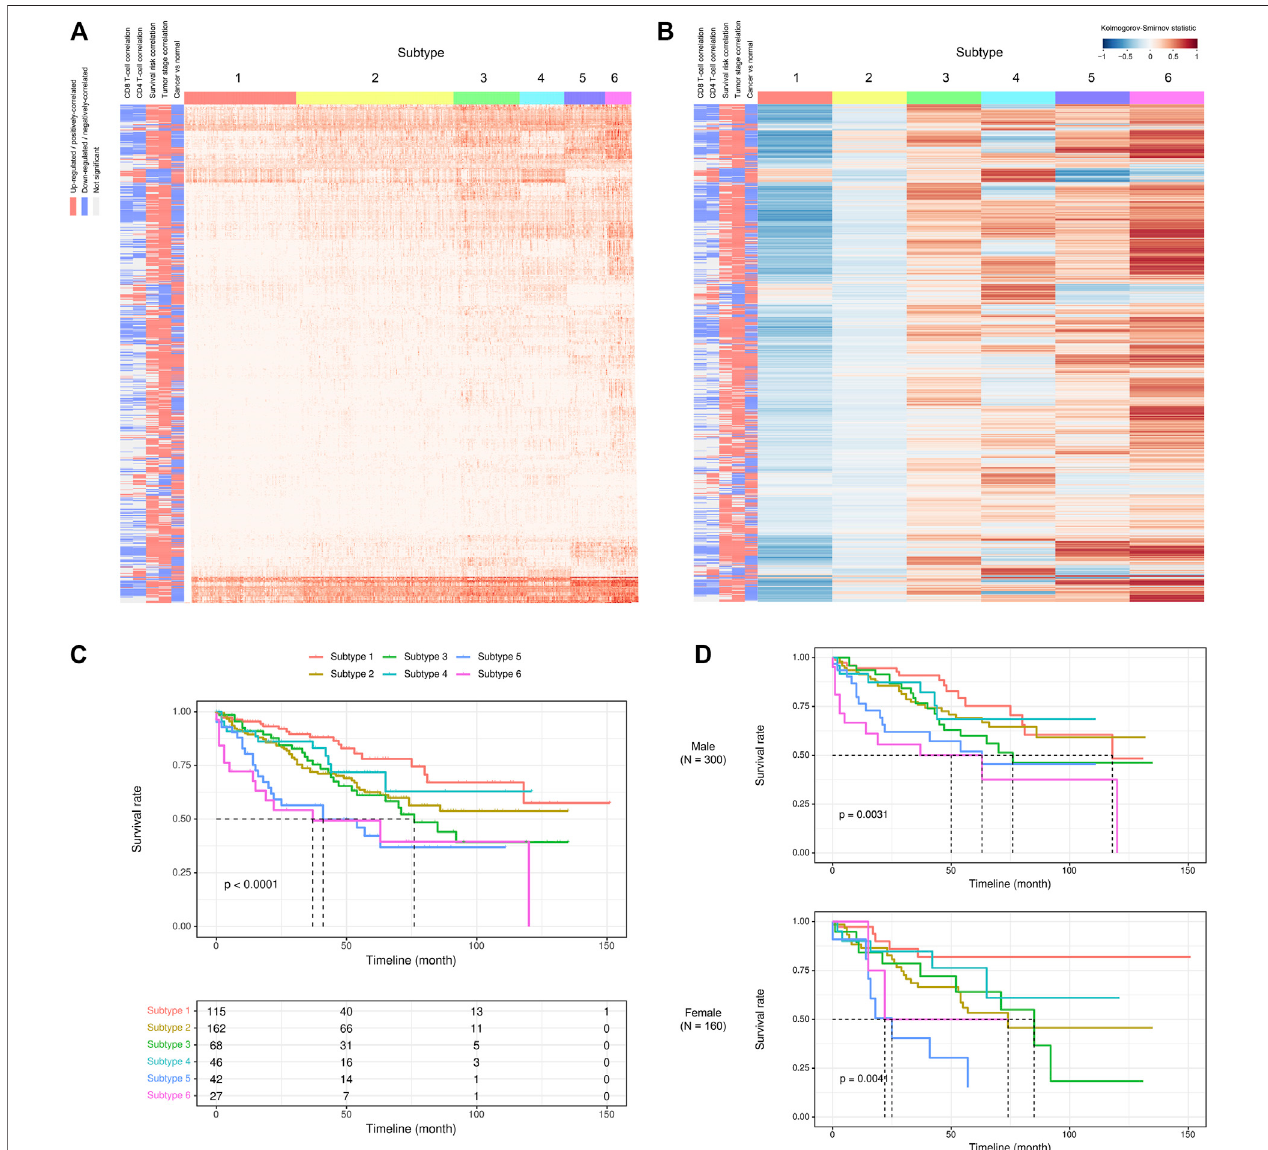
FIGURE7| ca-tRF-basedsubtypesandcorrespondingsurvivaldistinctioninKIRC. (A) Thesubtypessuggestedbyca-tRFexpressionpattern.Columnsandrows represent samples and ca-tRFs, respectively, and the color blocks along columns and rows represent subtypes and various ca-tRF-related biological features, respectively. (B) Heatmap of Kolmogorov-Smirnov statistics showing relative ca-tRF expression abundance across subtypes. (C) Kaplan-Meier plots showing the distinctionofsurvivalamongdifferentsubtypes. Therisktable showingthesamplenumber atriskisalsoshownbelowforreference. (D) Sex-speci fi cKaplan-Meier plots showing the distinction of survival among different